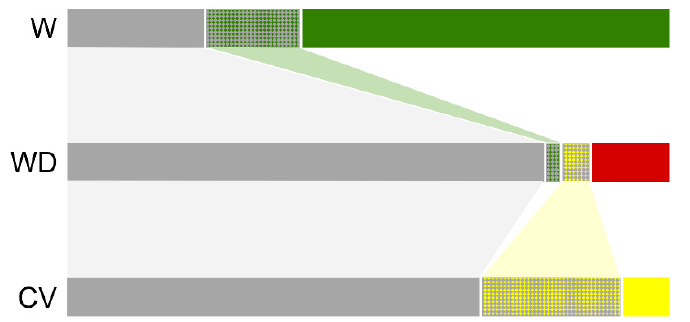
Figure 3. The proportion of different haplotypes of the qsh1 gene in wild (W), weedy (WD), and cultivated (CV) rice samples. The gray bars represent the haplotypes shared by wild, weedy, and cultivated rice samples. The light-green and light-yellow bars indicate the proportion of specific haplotypes shared by wild and weedy or by weedy and cultivated rice samples, respectively. The green, red, or yellow bars represent the proportions of unique haplotypes in the examined wild, weedy, or cultivated rice samples.